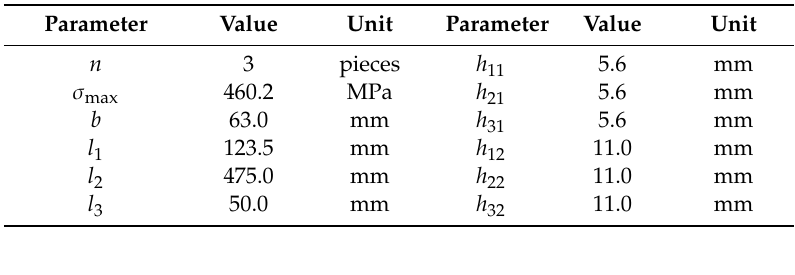
Table 1. The design parameters values.